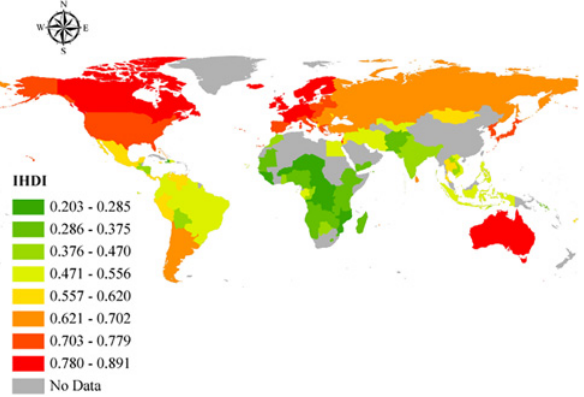
Fig 2. Geographic representation of the IHDI. Open source polygon feature data for the maps were downloaded [20] and, subsequently, projected using ESRI ArcGIS [21].